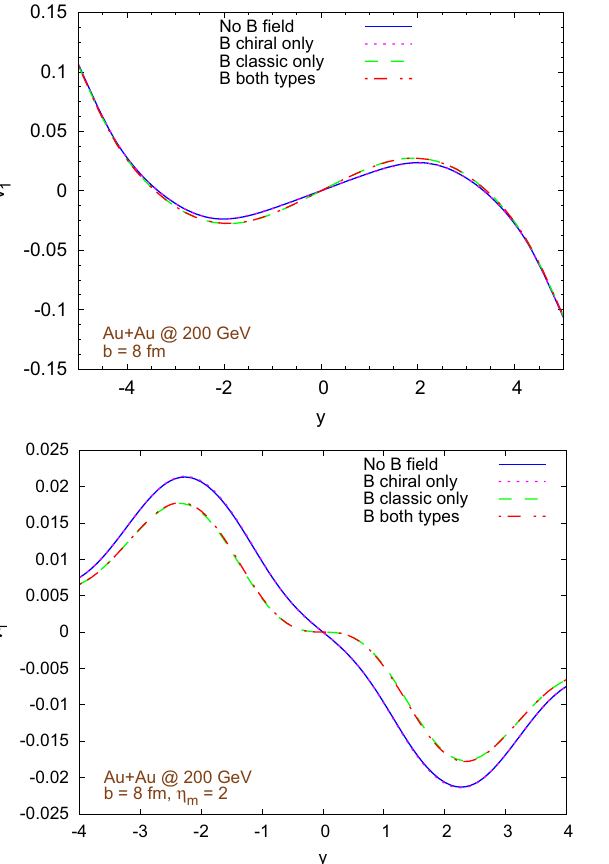
Fig. 6 Evaluation of the effects of the magnetic field having classic or chiral origin on v 1 ( y ) (left) and v 2 ( p T , y = 0 ) (right), for Au+Au col- √ s NN = 200GeV with b = 8fm. Top: Simulations with no lisions at